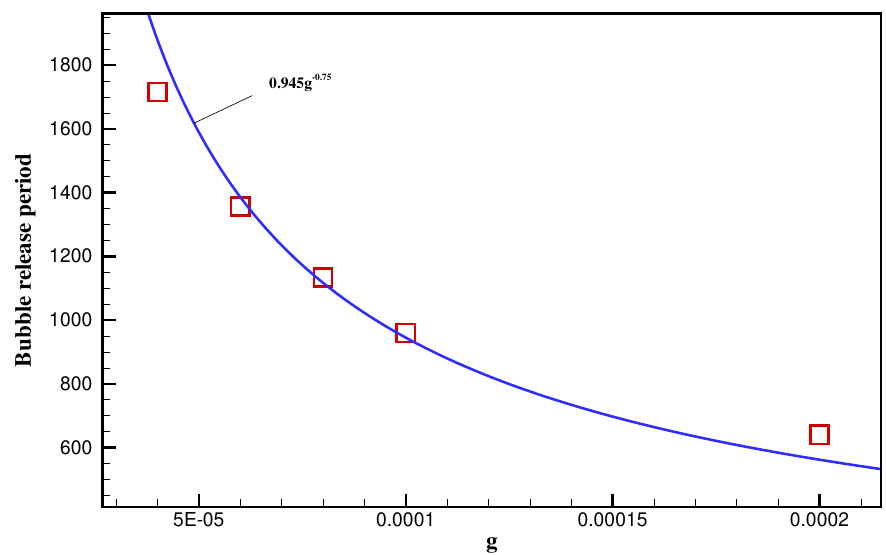
Figure 5. Bubble release period against different gravity numbers. Symbols: Simulation. The solid line represents a function 0.945 g − 0.75